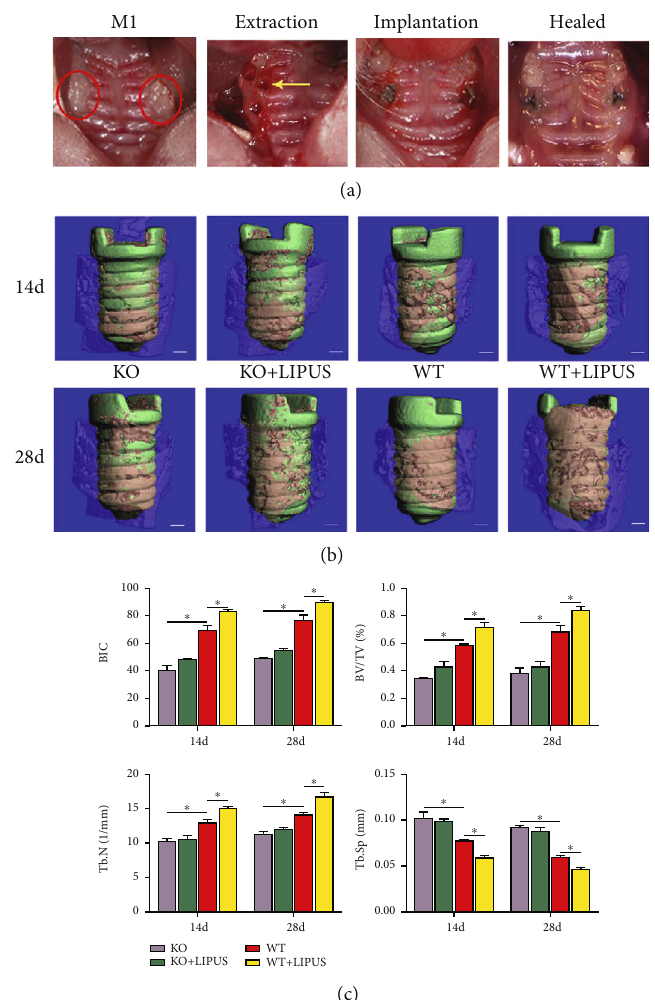
Figure 1: LIPUS enhanced the osseointegration of dental implant in α CGRP +/+ mice. (a) Tooth extraction and implant placement procedure. The red circles indicate bilateral maxillary fi rst molars. The yellow arrow points to the palatal root socket after tooth extraction. (b) Three-dimensional reconstruction of the implant by microcomputed tomography (micro-CT). The green area indicates implant, and the pink area indicates BIC. Scale bars = 100 mm . (c) Micro-CT analysis of BIC, BV/TV, Tb.N, and Tb.Sp. Data are presented as means ± standard deviation . ∗ P < 0 : 05 , n = 4 specimens/group. KO: α CGRP knockout mice; WT: wild type; BIC: bone